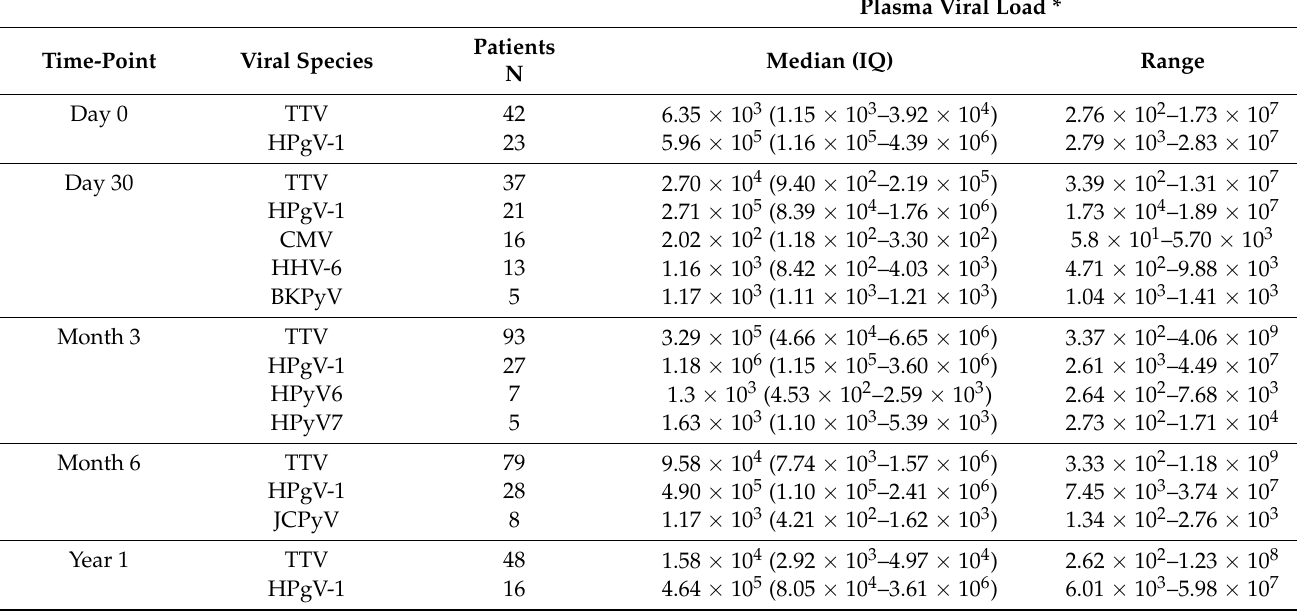
Figure 4. Dot plots of TTV and HPgV-1 plasma viral load at each time-point. The graphs are represented in a logarithmic scale to improve readability. Grey lines represent median plasma viral loads. Table 5. Plasma viral load of viral species detected in ≥ 5 patients at any time point.